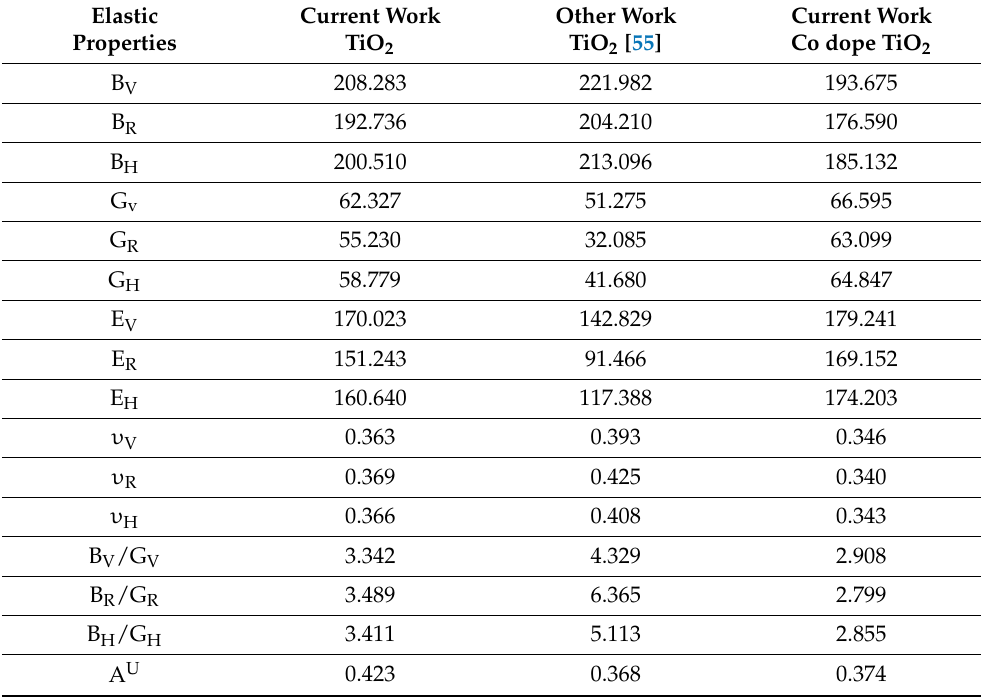
Table 4. Estimated elastic moduli and allied parameters of pristine and Co-doped TiO 2 .